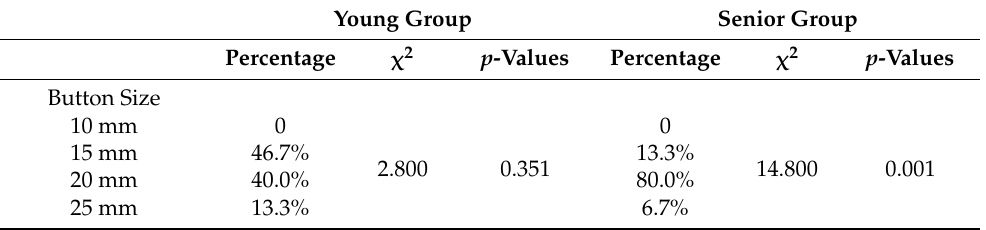
Table 6. Distribution of user preference by button size, graphics/text ratio, and icon